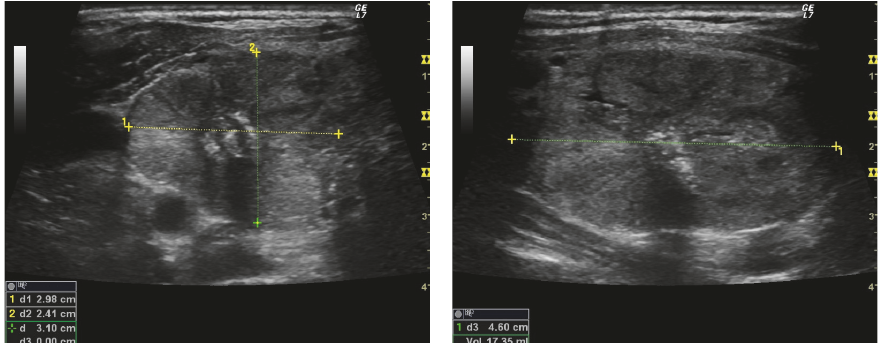
Figure 3: Right lobe thyroid nodule six months after laser